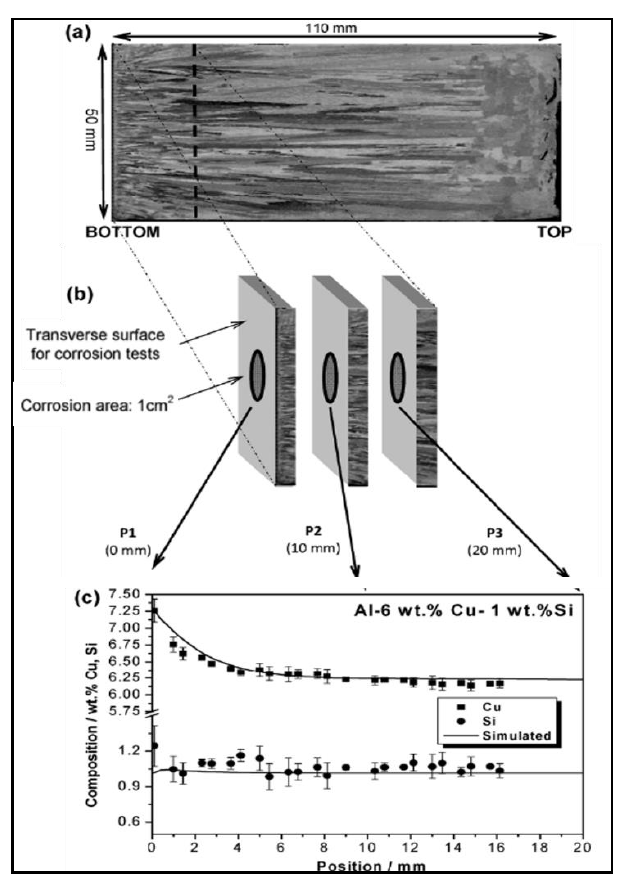
Figure 1. ( a ) Typical macrostructure of an Al–6 wt %, Cu–1 wt % Si alloy, ( b ) representation of the transverse surface samples used in the corrosion tests, and ( c ) experimental and simulated Cu and Si profiles corresponding to positions close to the casting surface highlighting the Cu macrosegregation. Reprinted with permission of [2].